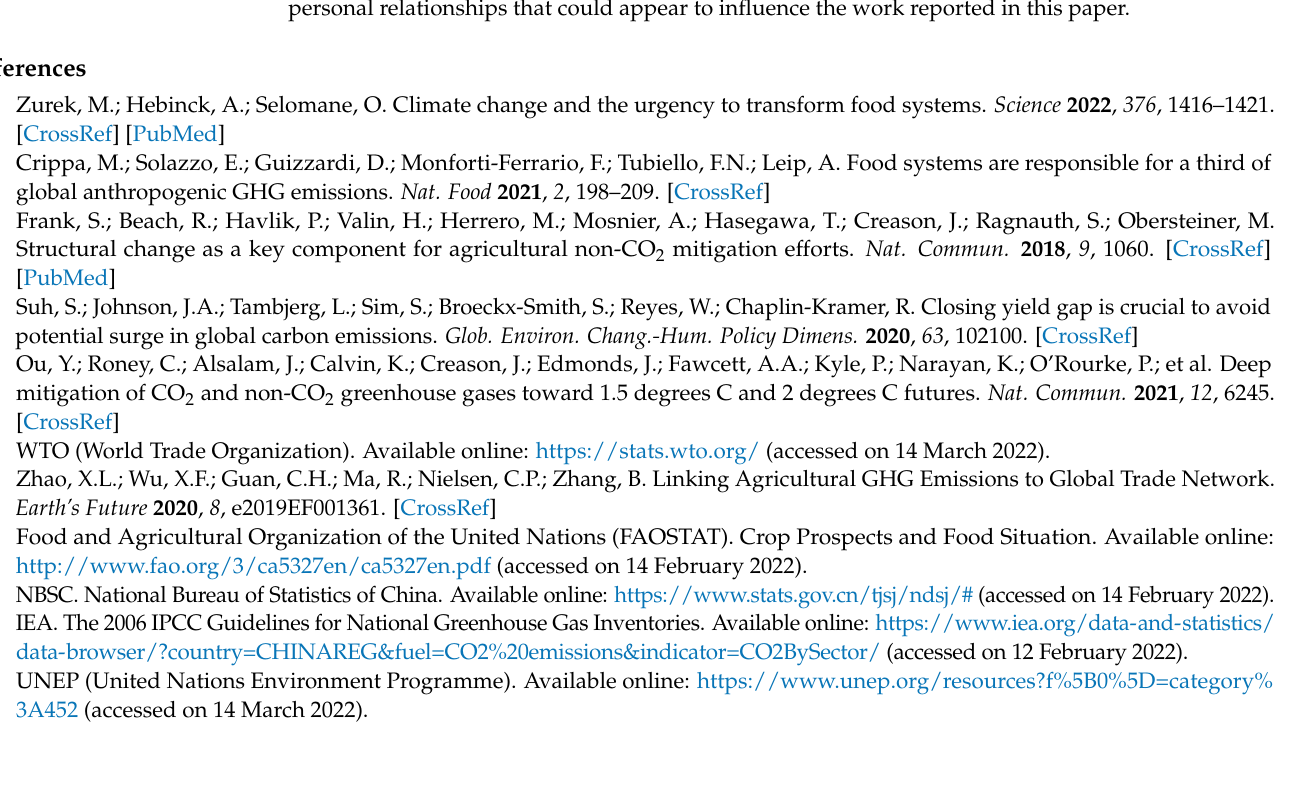
Table S2: The classification details and codes of China’s agricultural products, Table S3: Embodied GHG emissions in the exports of China’s agricultural products during 1995–2015, Table S4: The proportion of embodied GHG emissions in the exports during 1995–2015, Table S5: The embodied GHG emissions in the exports of China’s agricultural products to major countries in 2015, Table S6: The embodied GHG emissions in the imports of China’s agricultural products during 1995–2015, Table S7: The proportion of embodied GHG emissions in the imports during 1995–2015, Table S8: The embodied GHG emissions in the imports of China’s agricultural products from major countries in 2015, Table S9: The variation trend of net import and export volume of China’s agricultural products, Table S10: The variation trend of embodied GHG emissions in the net import and export of China’s agricultural products, Table S11: The embodied GHG emissions in the net imports of China’s agricultural products with major countries from 1995 to 2015, Table S12: The embodied GHG emissions in the net imports of China’s agricultural products with major countries in 2015, Table S13: The export volume of China’s agricultural products from 1995 to 2015, Table S14: The major export trading partners in 2015, Table S15: The import volume of China’s agricultural products from 1995 to 2015, Table S16: The major import trading partners in 2015, Table S17: Carbon emission factors (CEFs) of China’s trading partners of agricultural products provided by FAO. References [38,39,49] are cited in the supplementary